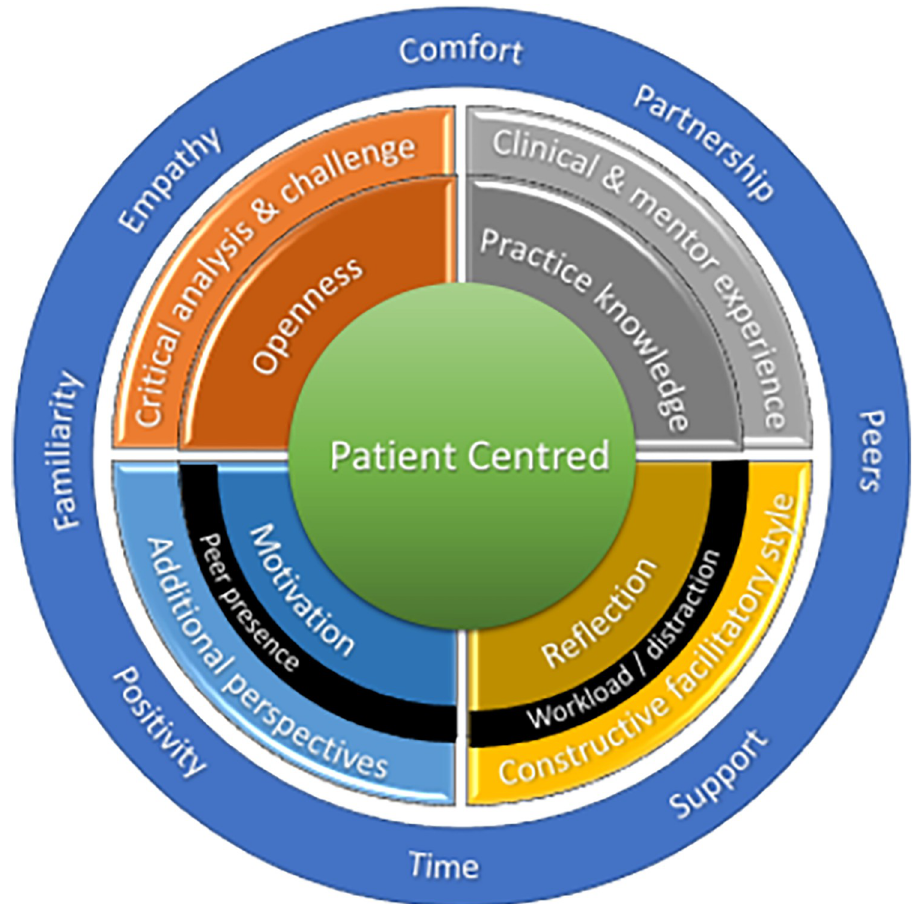
Fig 8. Environmental barriers to the emergent model of